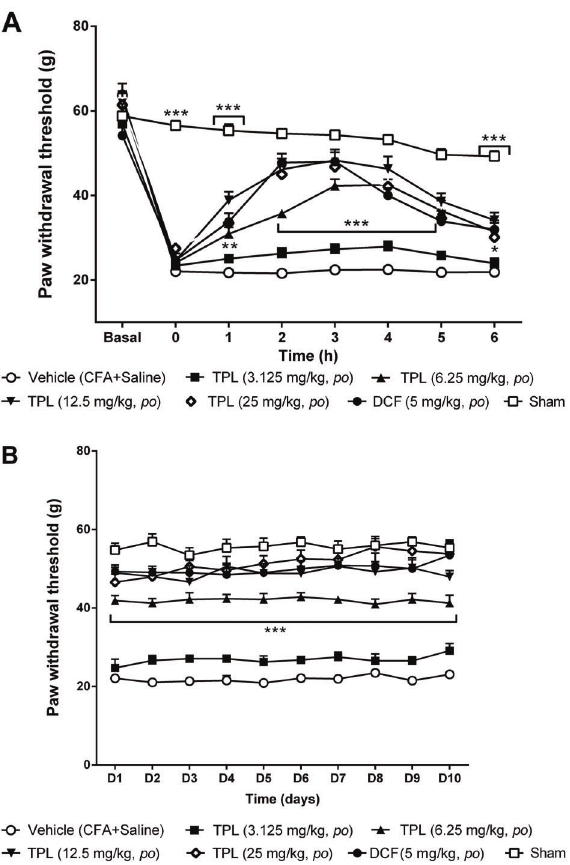
Figure 4. Effect of acute ( A ) and chronic ( B ) administration of terpinolene monoterpene (TPL). Each point represents the mean ± SEM of the paw withdrawal threshold in female Wistar rats (n=6 – 8) with mechanical hyperalgesia induced by Freund ’ s complete adjuvant (CFA) (50 m L/paw) injection ( ipl ) subjected to the Randall Selitto test. DCF: diclofenac. **P o 0.01 and ***P o 0.001 compared to vehicle group (two-way ANOVA, Bonferroni test). (Figure 8B) the association reduced the paw edema from D5 to D10 when compared to the vehicle group.